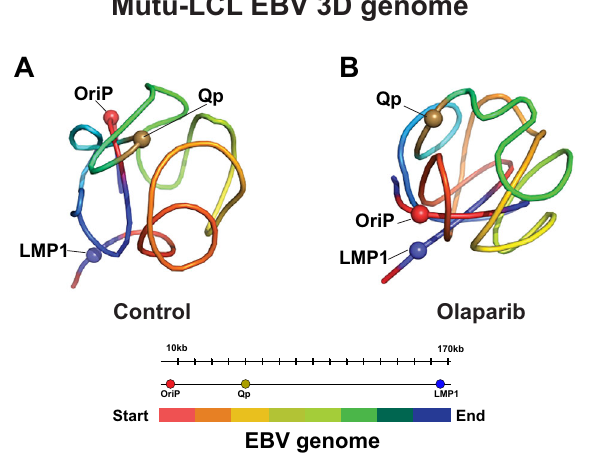
Fig. 6 Chromatin regulatory region localization is altered by PARP inhibition. PASTIS model displaying control type III EBV genome ( A ) or olaparib treated ( B ) with the color-coded legend of EBV genome. The model was derived from HiC pro fi les of the EBV episome found via global HiC analysis. Since cohesin is known to colocalize with CTCF across the type III EBV genome 18,19 , we additionally examined the cohesin binding pro fi les of the same cell lines, with and without PARP inhibition.